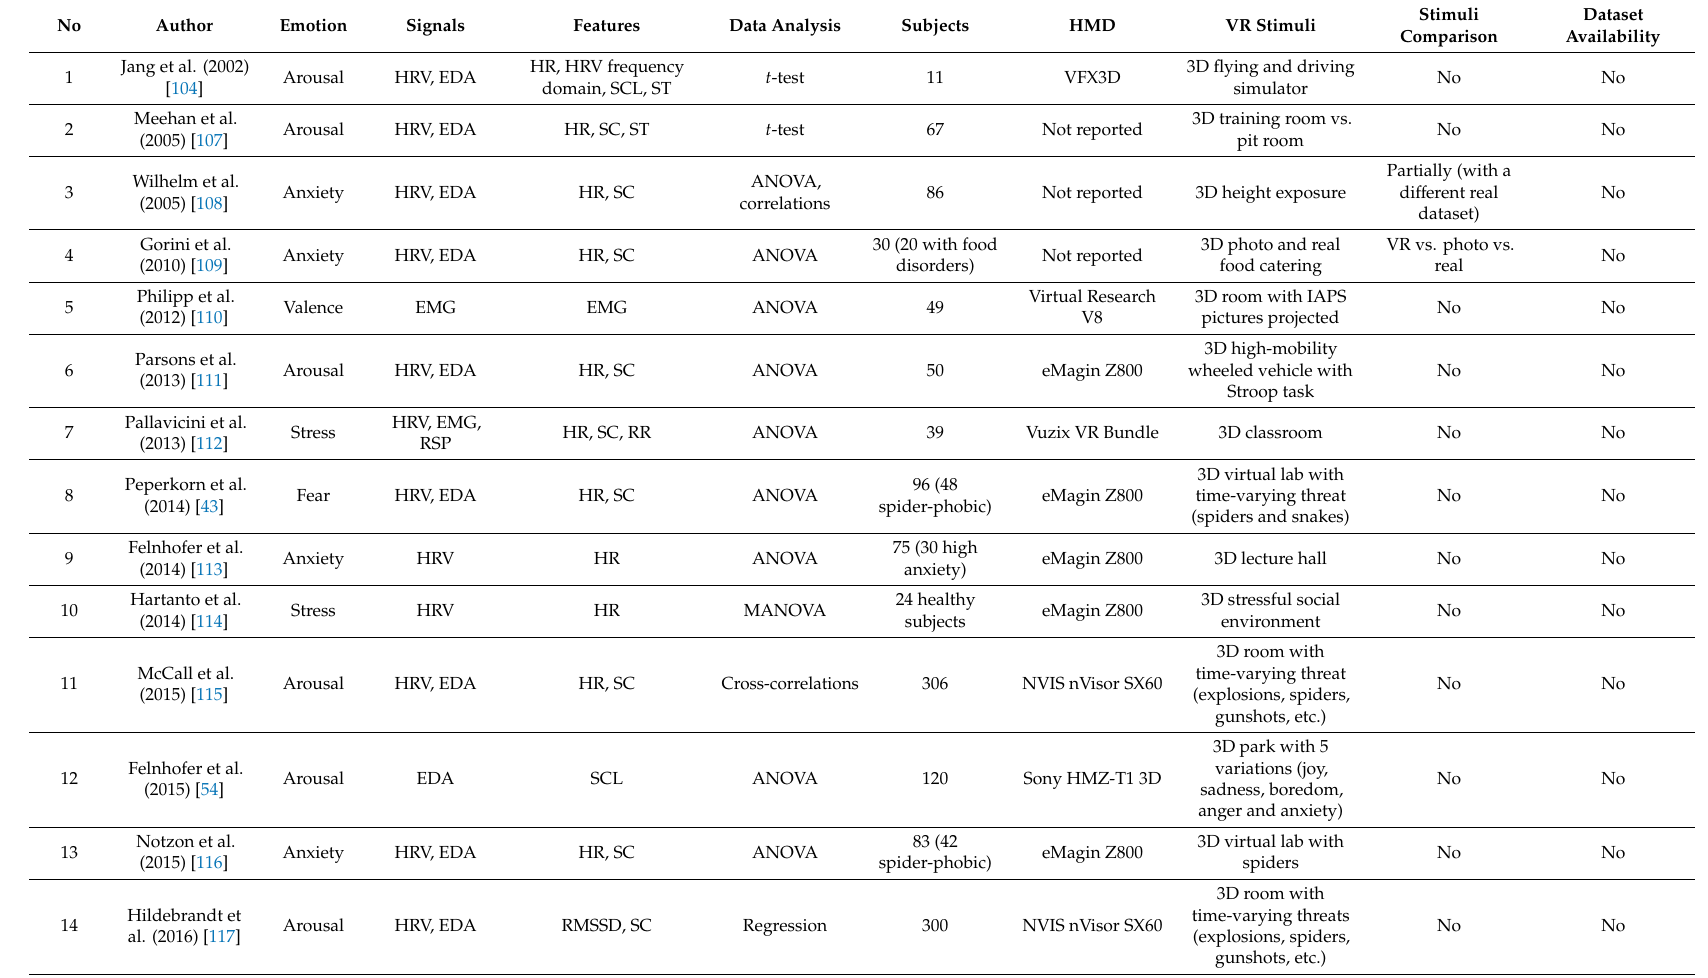
Table 2. Summary of previous